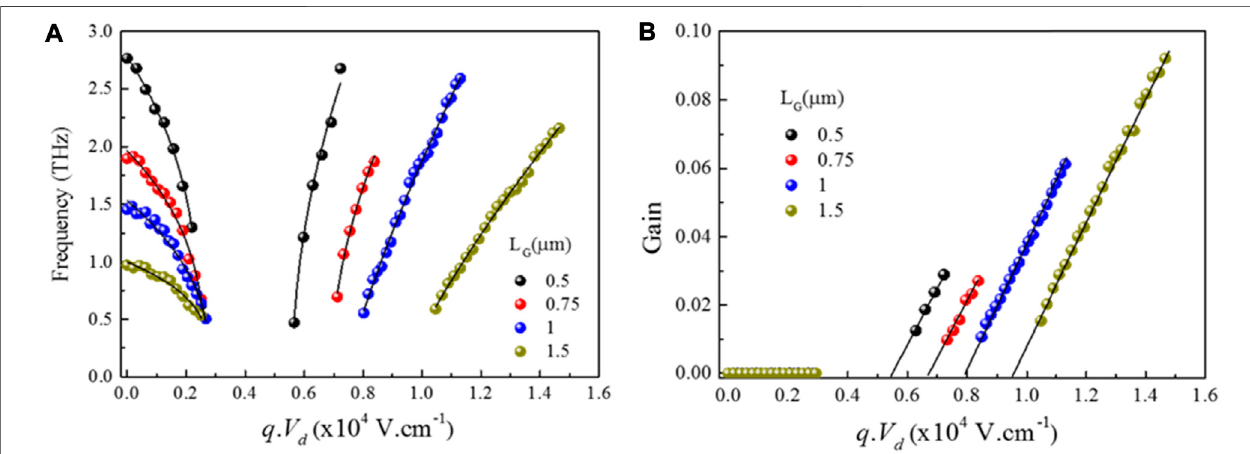
FIGURE 4 | Drain bias – dependent resonance frequencies (A) and gain (B) . Scaling laws of the measured graphene plasmon resonance frequency in the three devices as a function of qV d and fi ts to data shown as solid lines (A) . Maximal gain coef fi cient (minima of the negative extinction spectra) measured in devices A-DGG1 and A-DGG2 (B) . Clear threshold-like behavior is seen with onset fi eld intensities of ∼ 5.4 kV/cm (black dotes), ∼ 6.6 kV/cm (red dotes), ∼ 7.8 kV/cm (blue dotes), and ∼ 9.4 kV/cm (dark yellow dotes) in the four cavities. After Ref. 46.